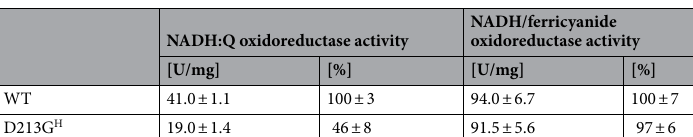
NADH:Q oxidoreductase activity